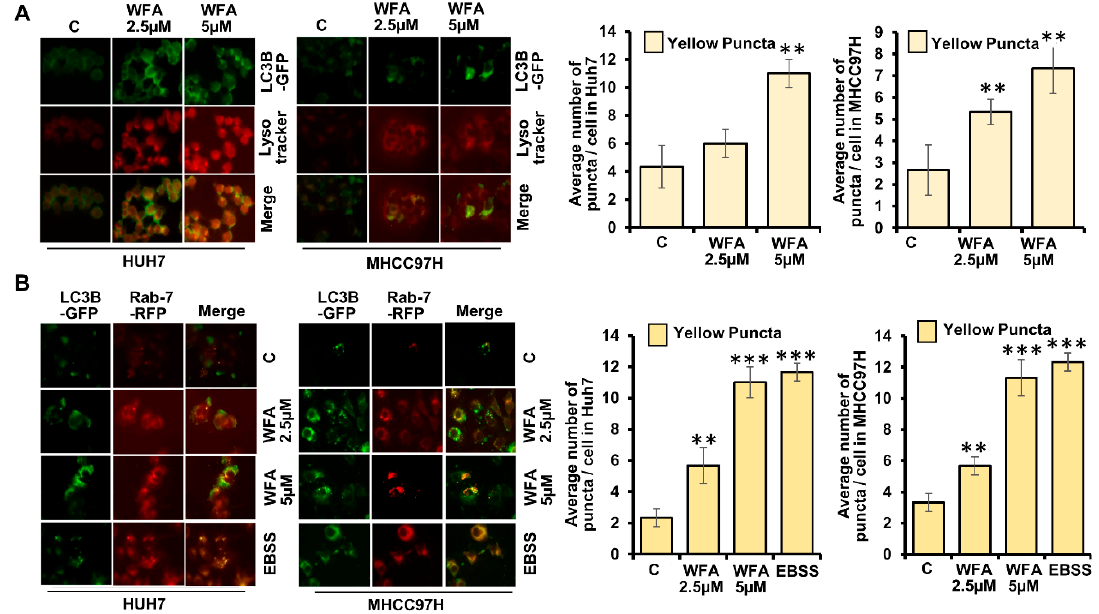
Figure 4. Withaferin A elevates the fusion of autophagosomes with lysosomes. ( A ) Huh7 and MHCC97H cells were transfected with GFP-LC3B encoding plasmid, treated with 5 µM of WFA or EBSS, followed by Lysotracker red staining. Representative fluorescence images are shown. Number of yellow puncta shown as bar graphs. ** p < 0.01, compared with control. ( B ) Huh7 and MHCC97H cells were co-transfected with GFP-LC3B and RFP-Rab7 followed by 5 µM WFA or EBSS treatment. Representative fluorescence images are shown here. Bar graphs show number of yellow puncta. ** p < 0.01, compared with control; *** p < 0.001, compared with control. Scale bar 10 µm.